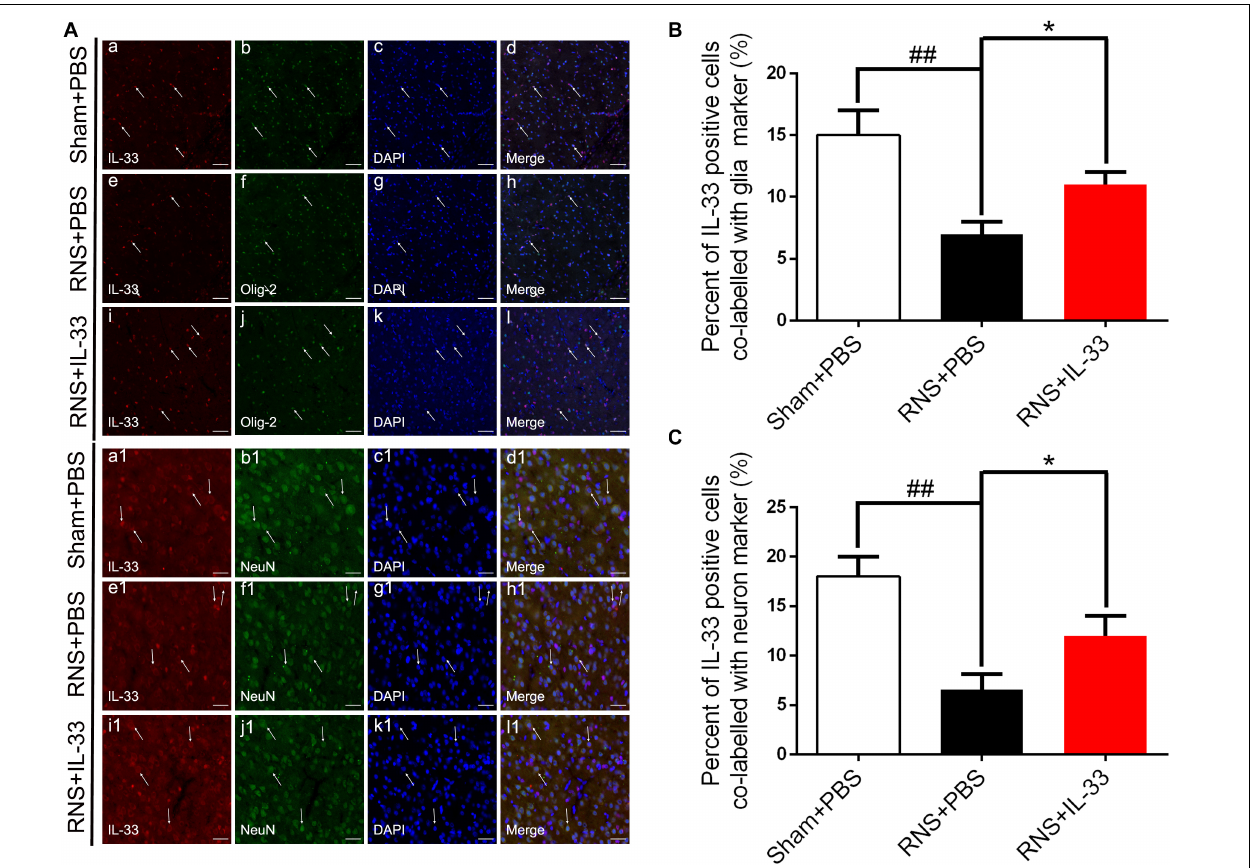
FIGURE 2 | The expression and co-localization of IL-33 in cerebral cells and tissues after RNS. (A) Representative images of double labeling were indicated with white arrows after RNS. (a-l) The co-localization of IL-33-like immunoreactivity and Olig-2-positive. Bar 50 µ m. (a1–l1) Co-localization of IL-33-like immunoreactivity and NeuN-positive neurons. Bar 50 µ m. (B,C) Semi-quantitative analysis of glia and neuron type-cells contributions to the IL-33-positive cell population. The data were expressed as means ± SEM ( n = 6). ## P < 0.01 vs. Sham + PBS group. * P < 0.05 vs. RNS + PBS group. Experiments are representative of three independent